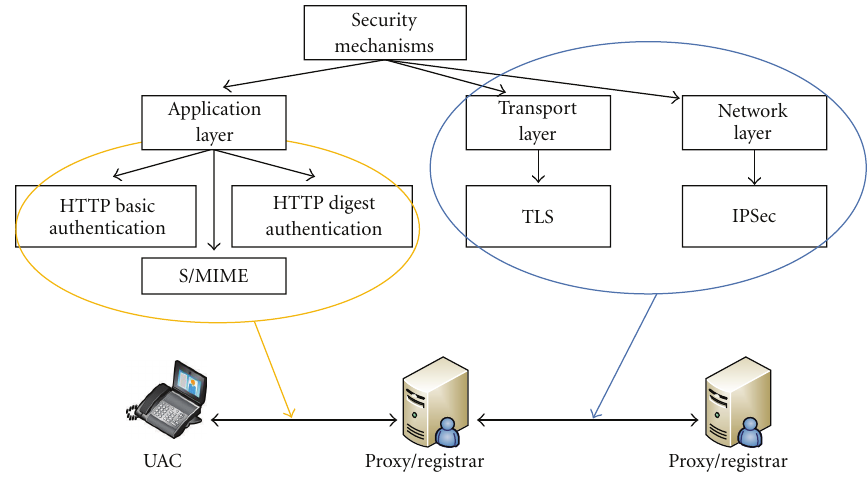
Figure 5: SIP security